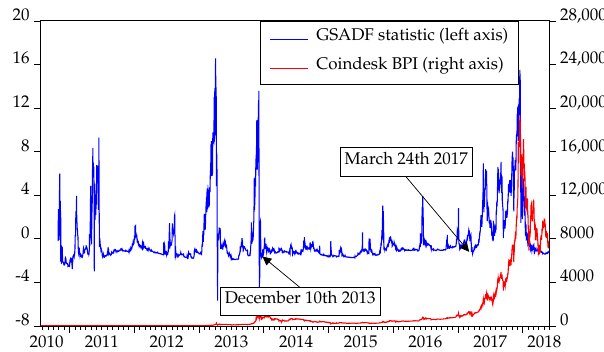
Figure A1. Coindesk BPI and the generalized sup augmented Dickey–Fuller statistic. Notes: The final GSADF statistic is the largest ADF statistic, which in the figure is above 16. The asymptotic 99% critical value for an initial window 5.5% (ours is 3.5%) of the total sample is 2.74 based on numerical simulations with 2000 replications (Phillips et al. 2015). Given that the test statistic exceeds this value in some point (actually multiple) in the sample, there is evidence of bubbly behavior. The corresponding asymptotic critical value for the supremum ADF (SADF) tests constituting the GSADF test is 2.06, providing evidence of multiple cases of bubbles.